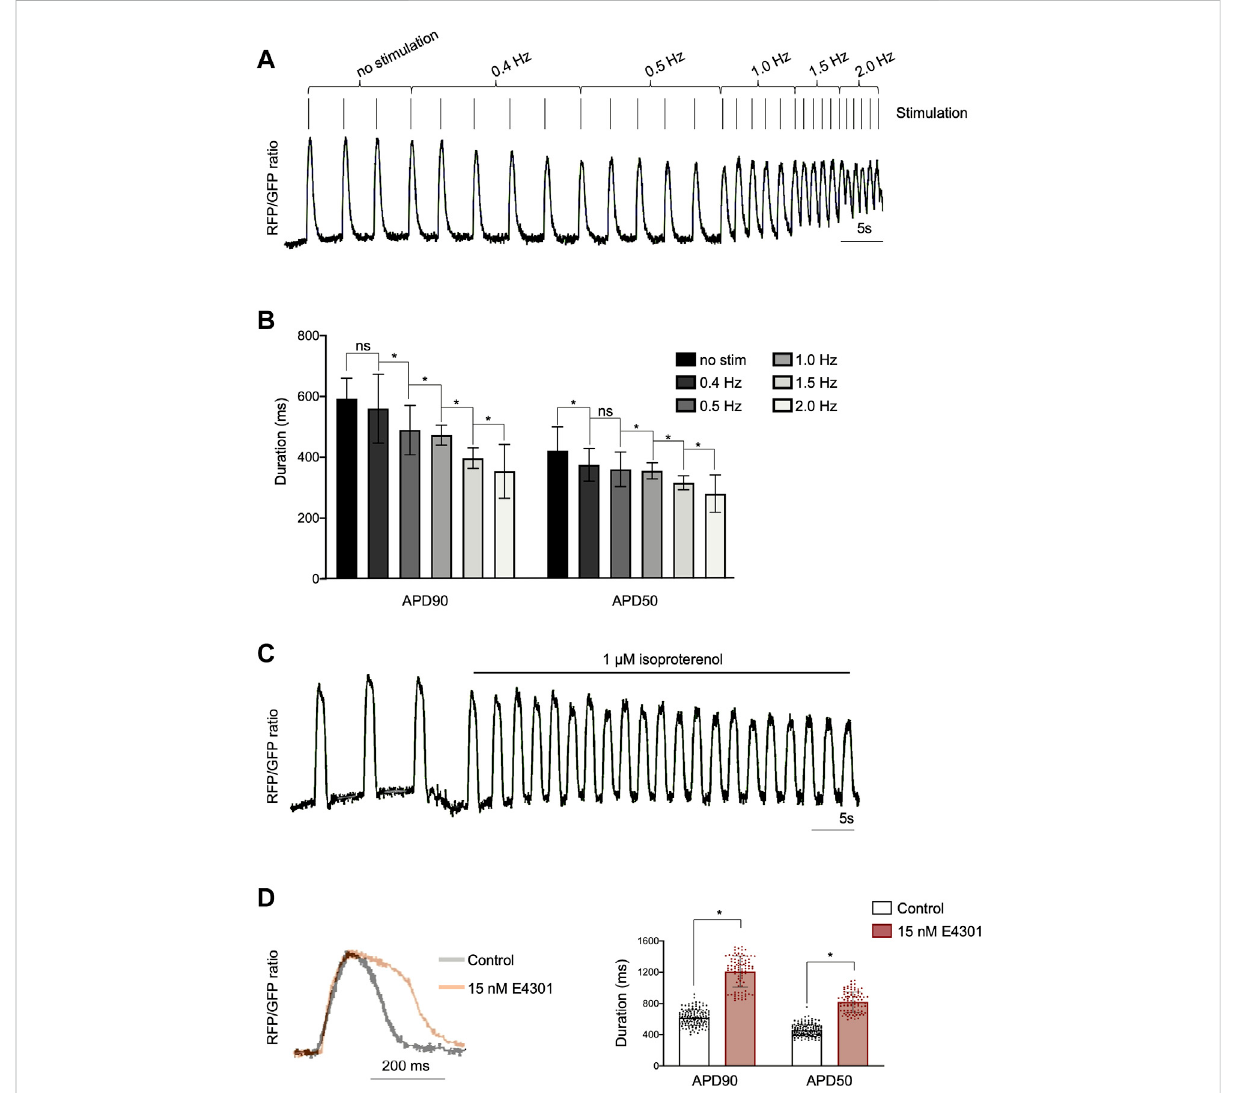
FIGURE 2 Optical imaging of APs in AAVS1-VSFP-hiPSC-vCMs under electrical stimulation and drug treatment. (A) AP traces of homozygous d60 AAVS1- VSFP-hiPSC-vCMs with increasing electrical stimulation from 0.4 Hz to 2 Hz. (B) Quanti fi cation of APD90 and APD50 in d60 homozygous AAVS1- VSFP-hiPSC-vCMs under electrical stimulation from 0.4 Hz to 2 Hz. No stim: no stimulation. Data are mean ± SD; N = 184 vCMs from n = 3 differentiations; * p < 0.005 (Kruskal-Wallis test). (C) AP traces of homozygous d60 AAVS1-VSFP-hiPSC-vCMs before and after 1 μ M isoproterenol treatment. (D) AP traces (left panel) and quanti fi cation of APD90 and APD50 (right panel) in d60 homozygous AAVS1-VSFP-hiPSC- vCMswithorwithout(control)15 nME4031treatment.Dataaremean±SD; N =88withE4031and N =144withouttreatment(control)homozygous vCMs, n = 3 differentiations; * p < 0.0001 (Mann-Whitney